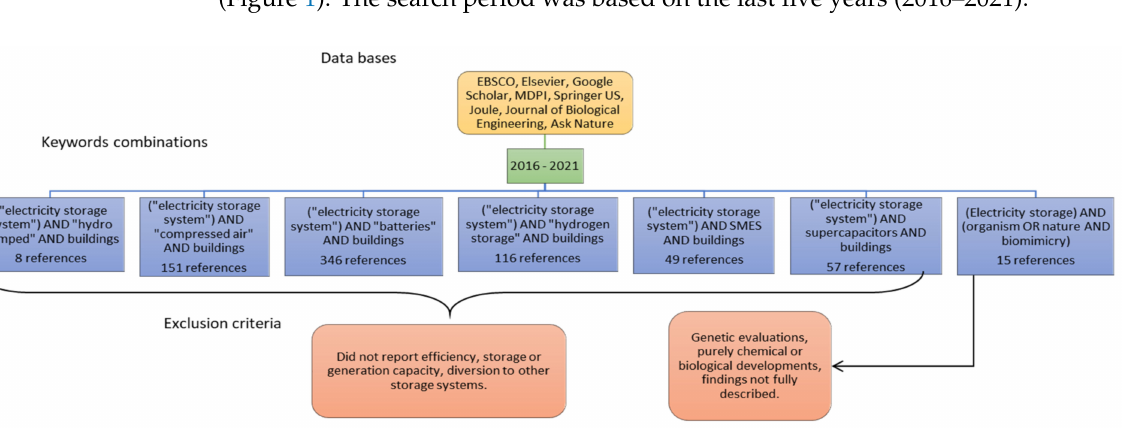
Figure 1. Literature search strategy. Own